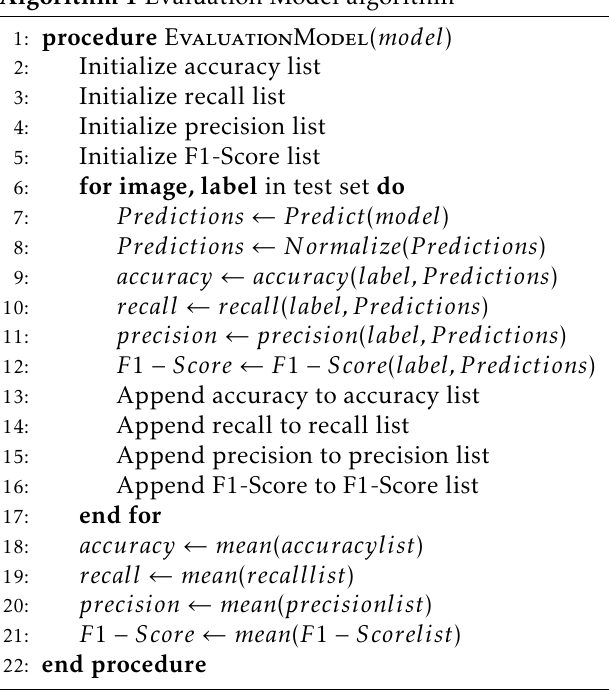
Algorithm 1 Evaluation Model